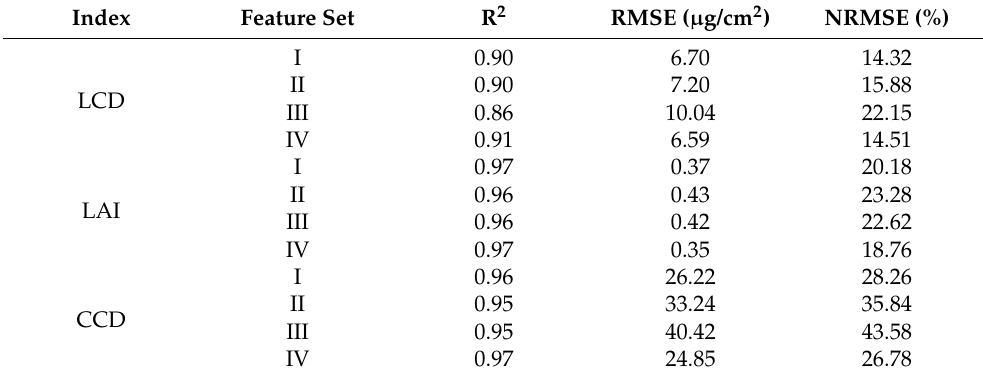
Table 4. Four feature sets were used for RF method estimation of LCD, LAI, and CCD.